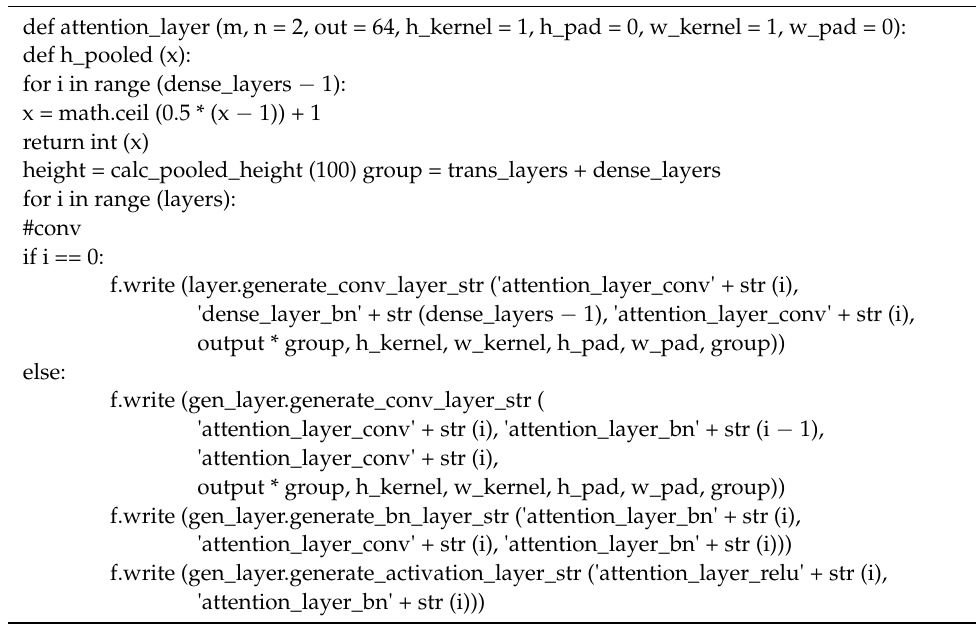
Algorithm 1: Pseudo code of the algorithm